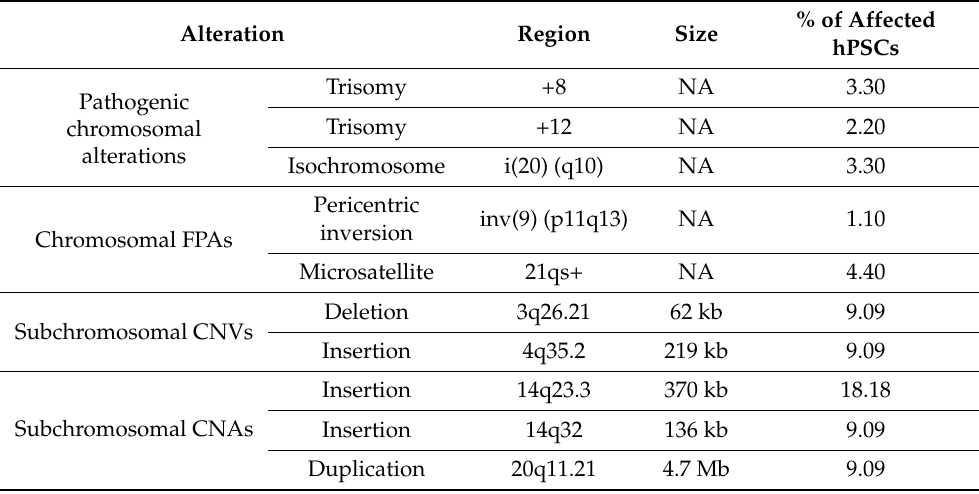
Table 6. List of de novo chromosomal (FPAs and pathogenic alterations) and subchromosomal (CNVs and CNAs) detected by G-banding and aCGH, respectively, in post-adaptation hPSCs. Alteration